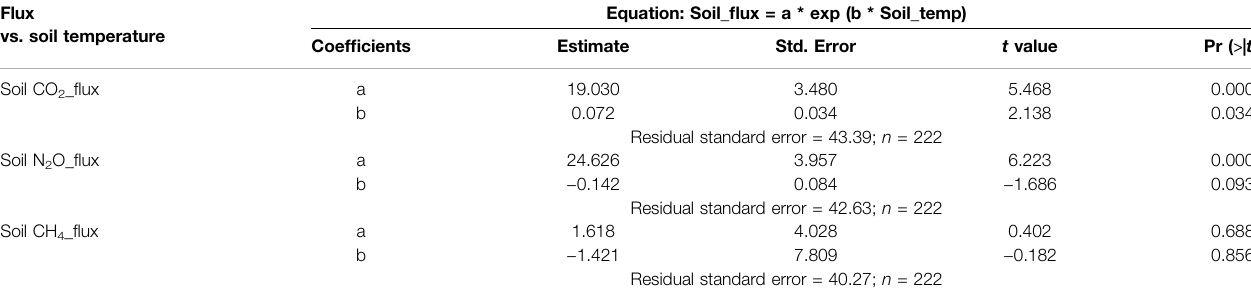
TABLE 4 | Relationship between greenhouse gas fl uxes and soil temperature (~10 cm) using exponential model during the 2021 spring freeze-thaw events. Flux vs. soil